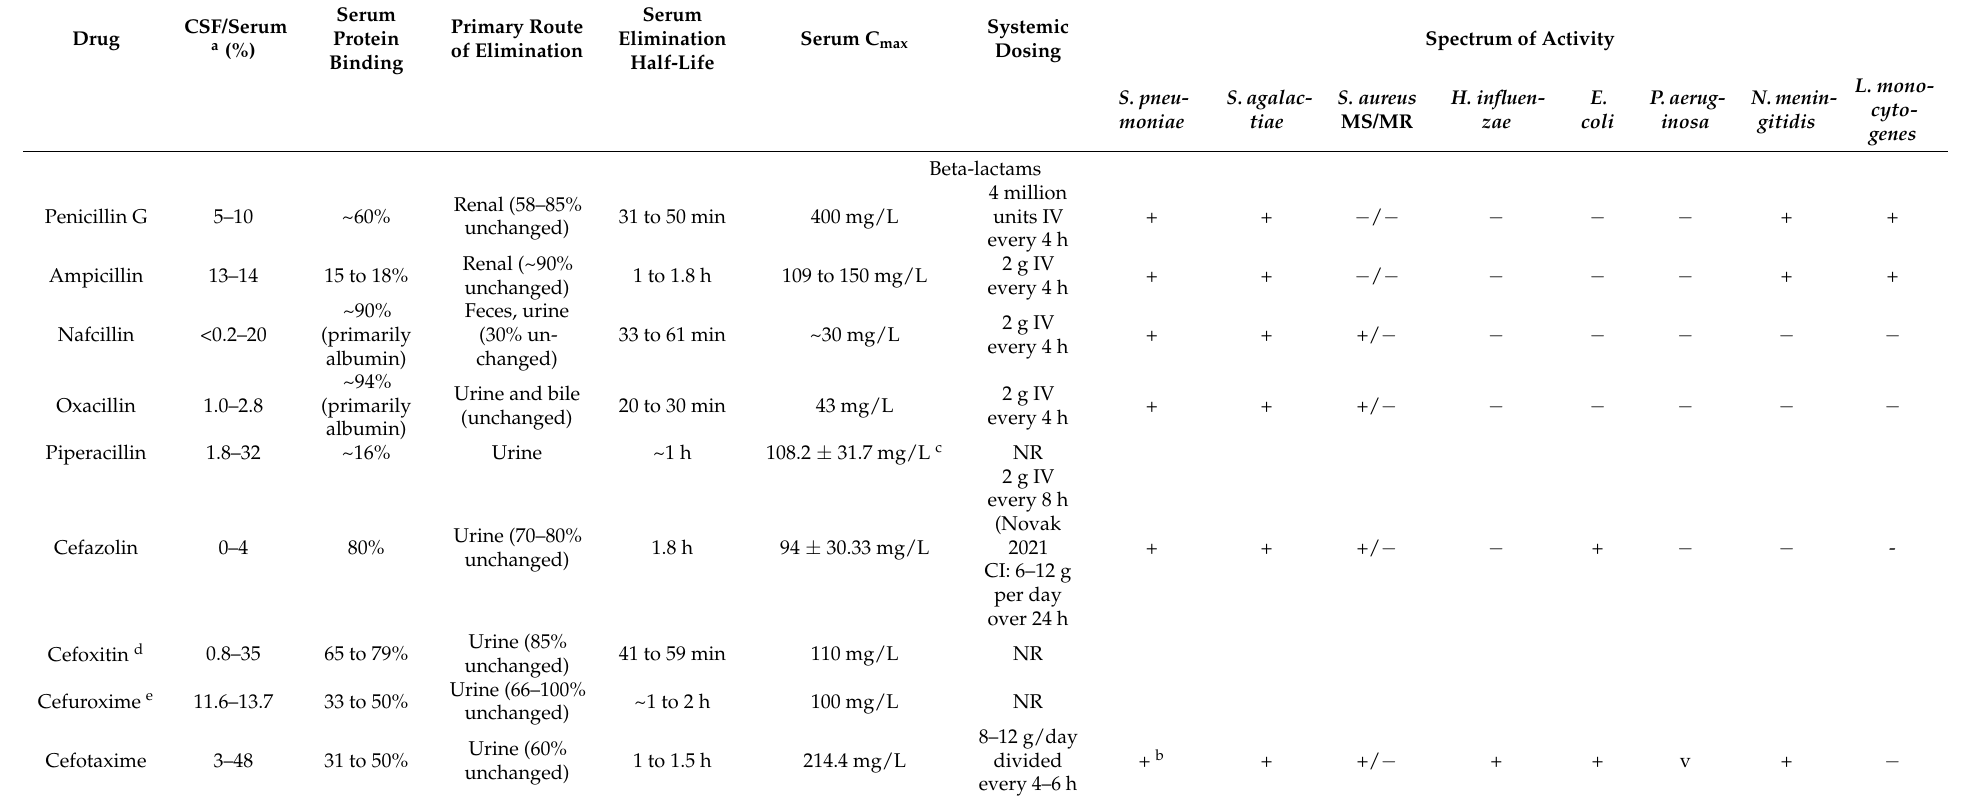
Table 1. Beta-lactam antimicrobial drugs and their PK/PD